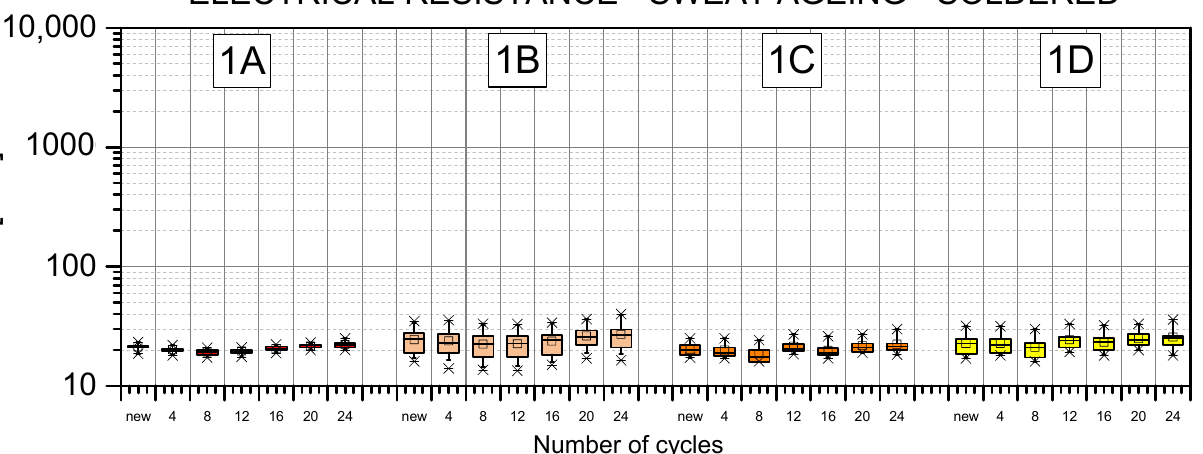
Figure 6. Boxplot diagram of soldered joint (first sample type) electrical resistance for samples 1A, 1B, 1C and 1D.